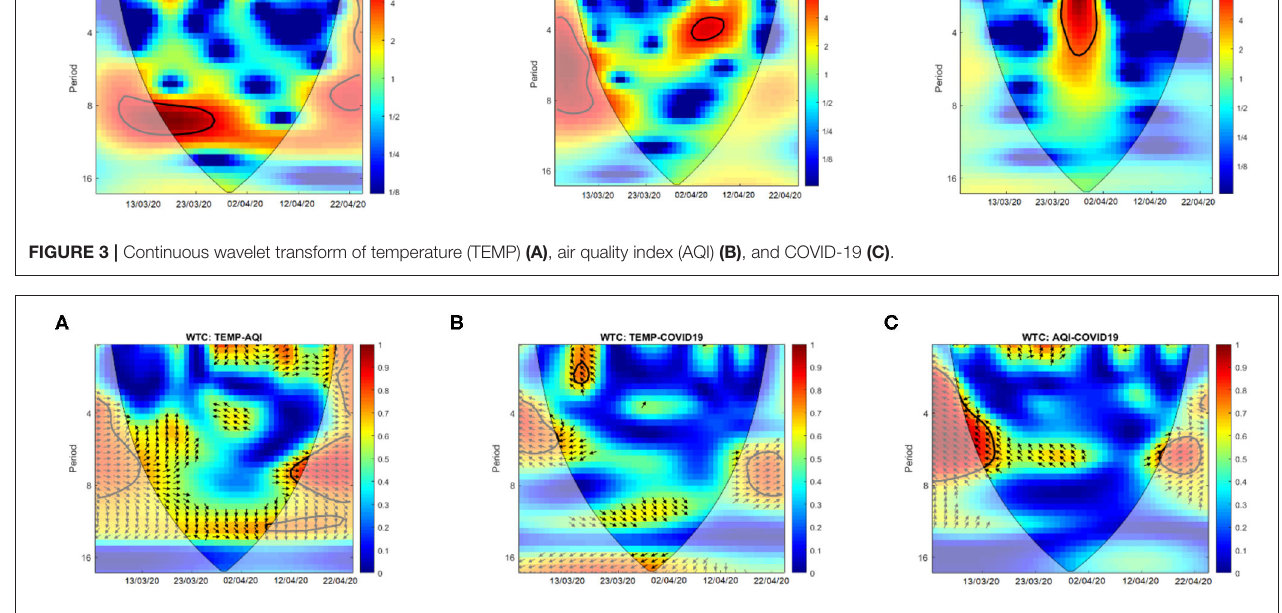
FIGURE 4 | Wavelet Coherence transform of TEMP (A) , AQI (B) and COVID-19 (C) .